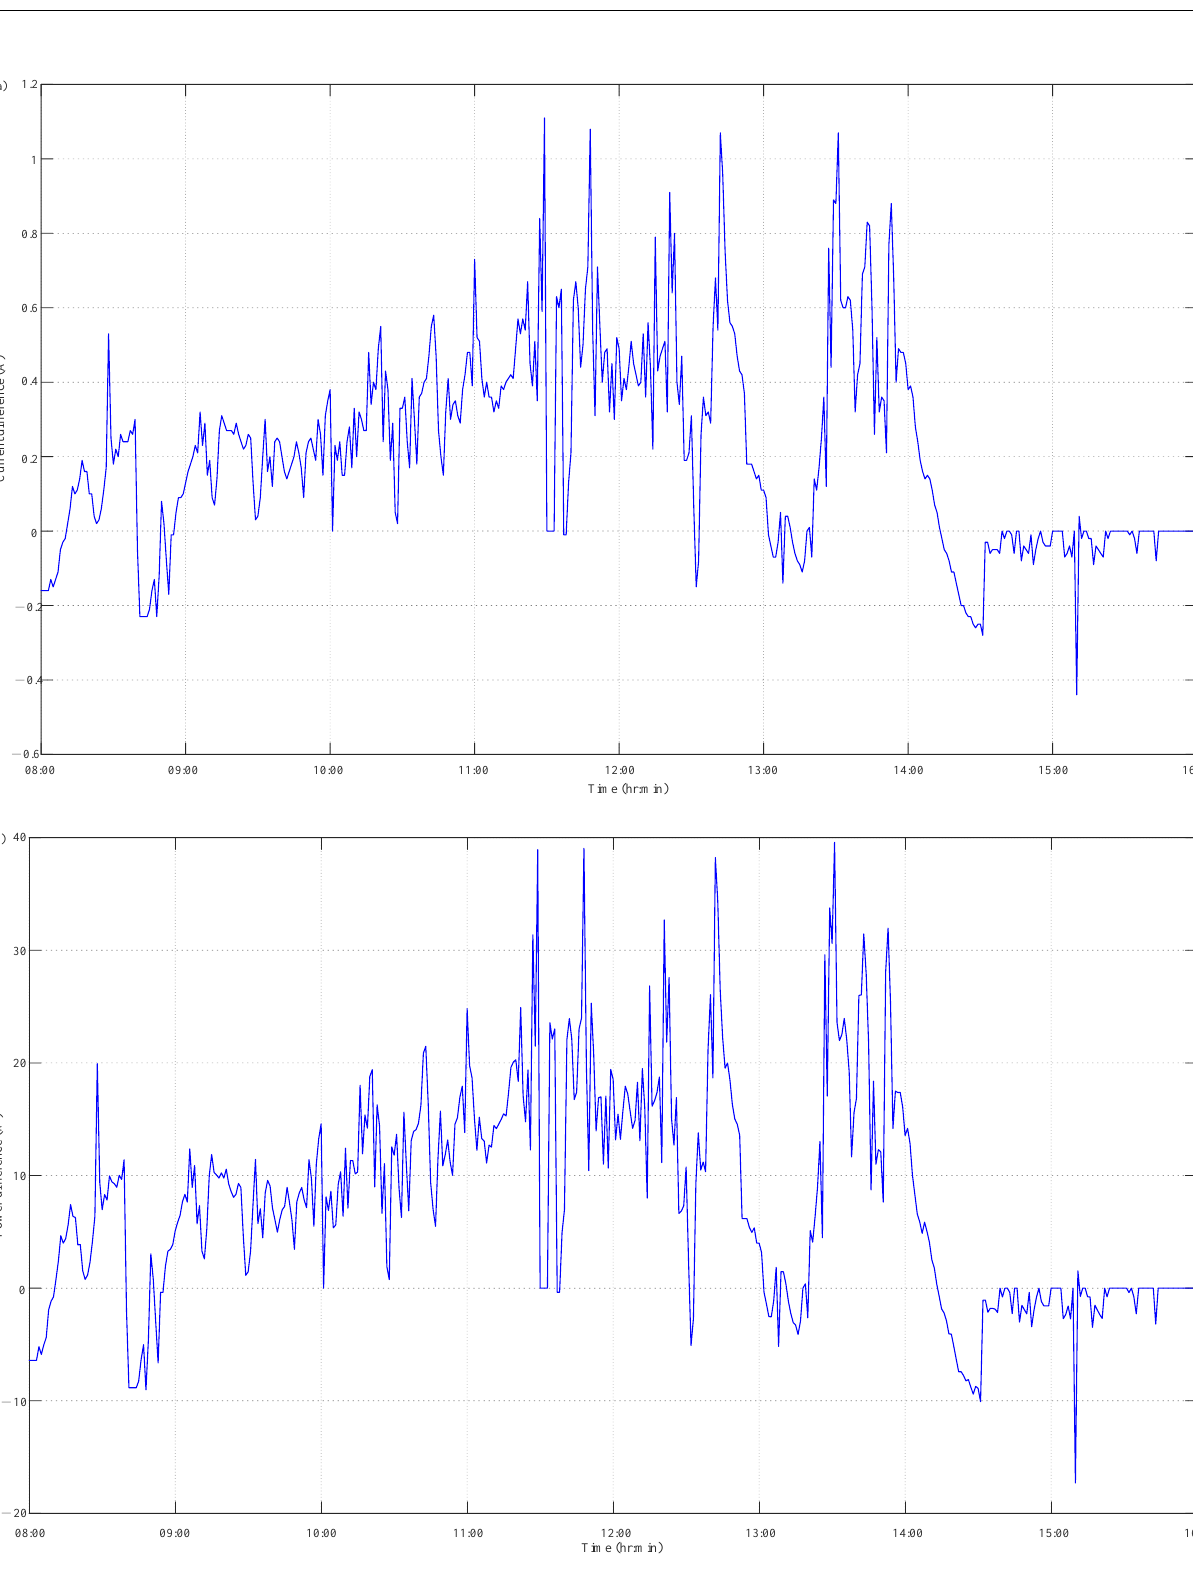
Figure 8. Simulated and measured results of PVEFD system: ( a ) output current; ( b ) output power. Table 3. Accuracy analysis of PVEFD system.